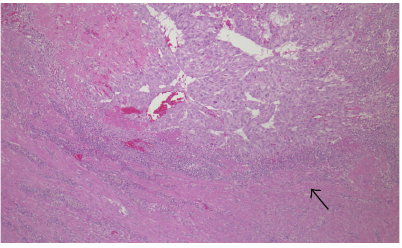
Figure 1: H & E. Liver core biopsy with nests of malignant epithelioid cells with eosinophilic cytoplasm. Figure 2: H & E. Mononucleate epithelioid tumor cells, rimmed by a lymphocytic infiltrate (arrow).